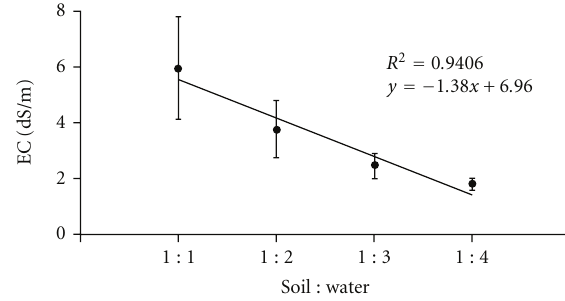
Figure 2: EC level and soil: water solution